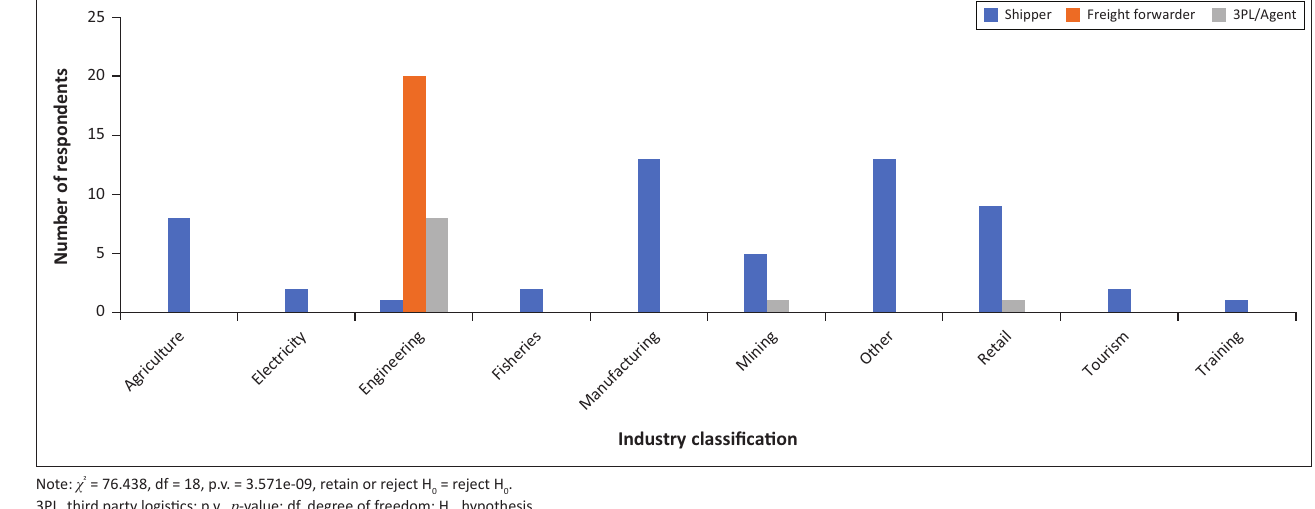
FIGURE 4: Decision-maker by business